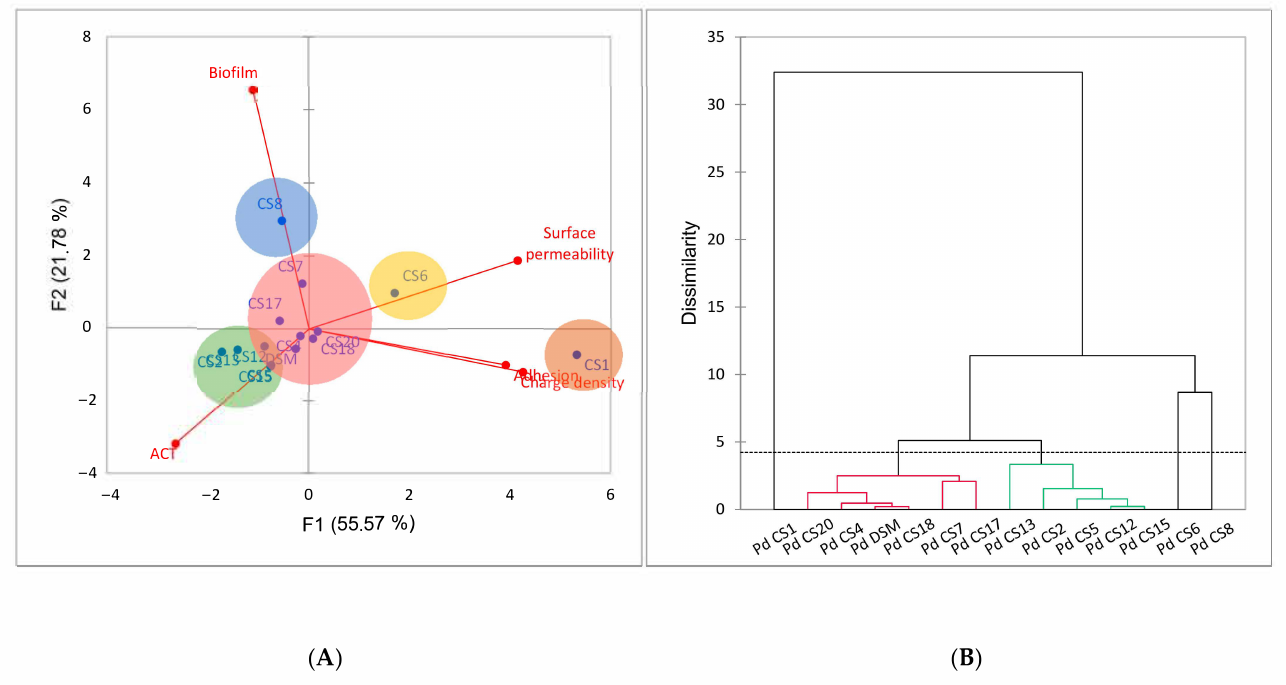
Figure 3. ( A ) Two-dimensional principal component (2-D PCA) analysis biplot showing relationships amongst the charge density ( ρ 0 /F), the surface permeability (1/ λ o ), the homo-aggregation coefficient (ACT), the adhesion and biofilm formation capacities of P. distasonis strains with a F1 and F2 of 77.35%. ( B ) Dendrogram representing clustering of P. distasonis strains based on the similarity of their capacities analyzed by hierarchical agglomerative clustering (HAC). The dotted line characterizes the automatic truncation, leading to five groups identified with circles in the 2-D